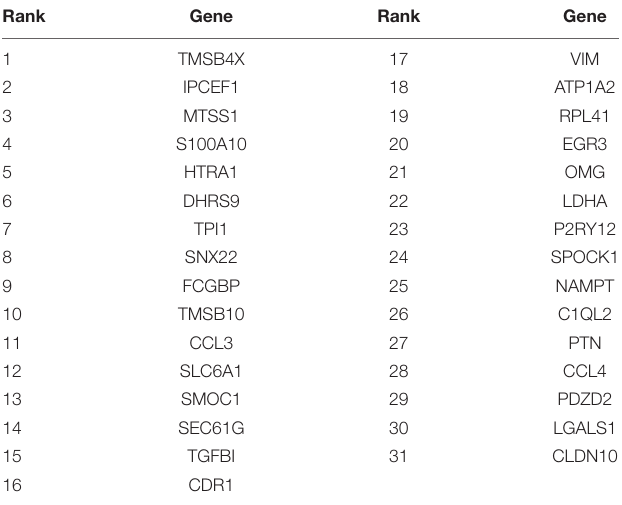
TABLE 1 | The 31 selected GBM biomarker genes.